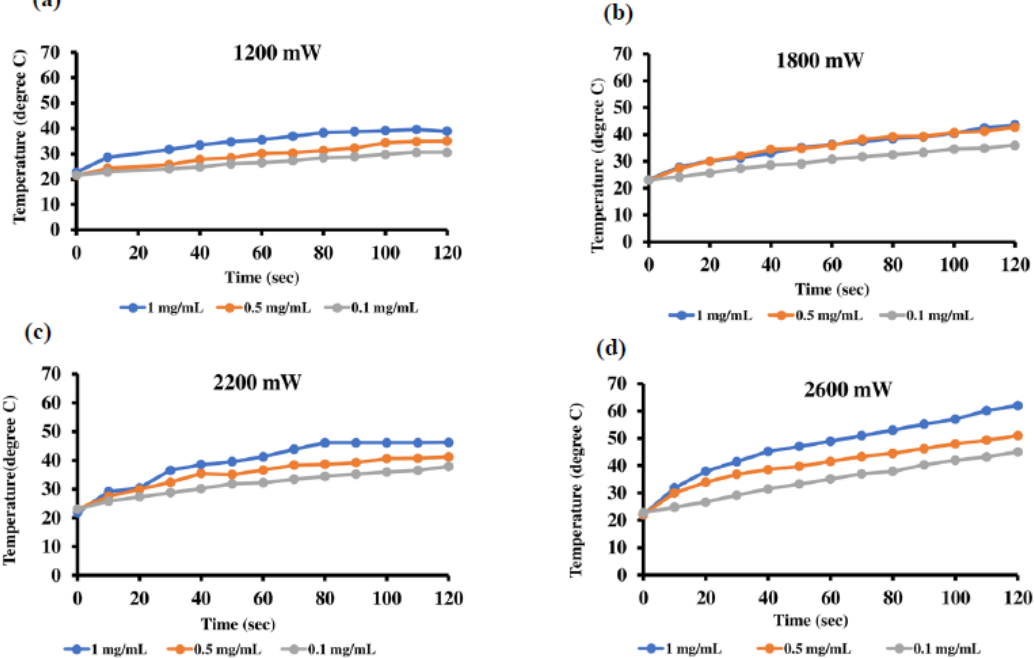
Figure 4. The photothermal evaluations of laser absorption of WS 2 sheets in various laser power densities of ( a ) 1200, ( b ) 1800, ( c ) 2200 and ( d ) 2600 mW at concentration 1, 0.5 and 0.1 mg/mL.